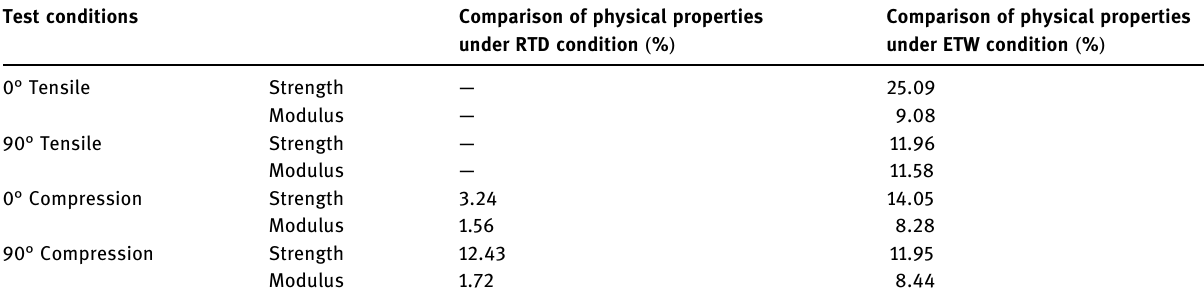
Table 4: Comparison of physical properties of the results of the fi rst and second equivalency tests Test conditions Comparison of physical